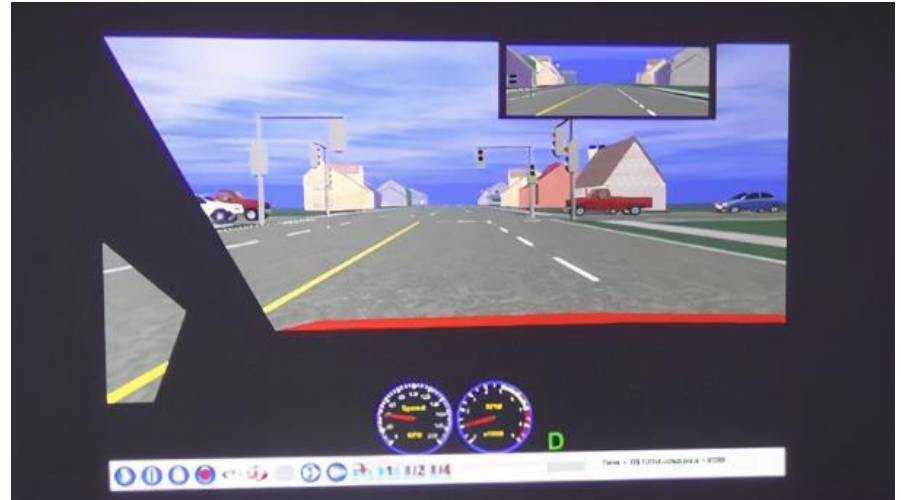
Figure 1. Example (still) of driving simulator video clip presented to participants.